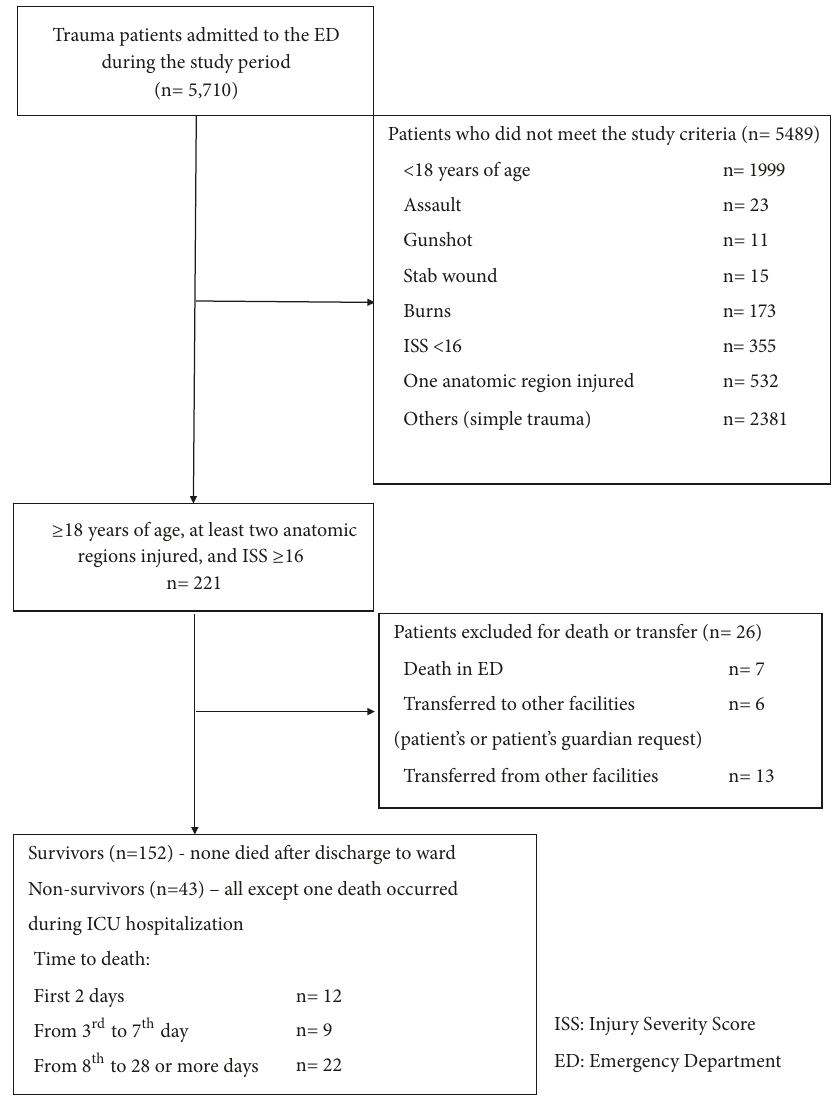
Figure 1: Flow chart depicting the total trauma patients admitted during the study period and the patients ultimately enrolled after applying the various inclusion and inclusion